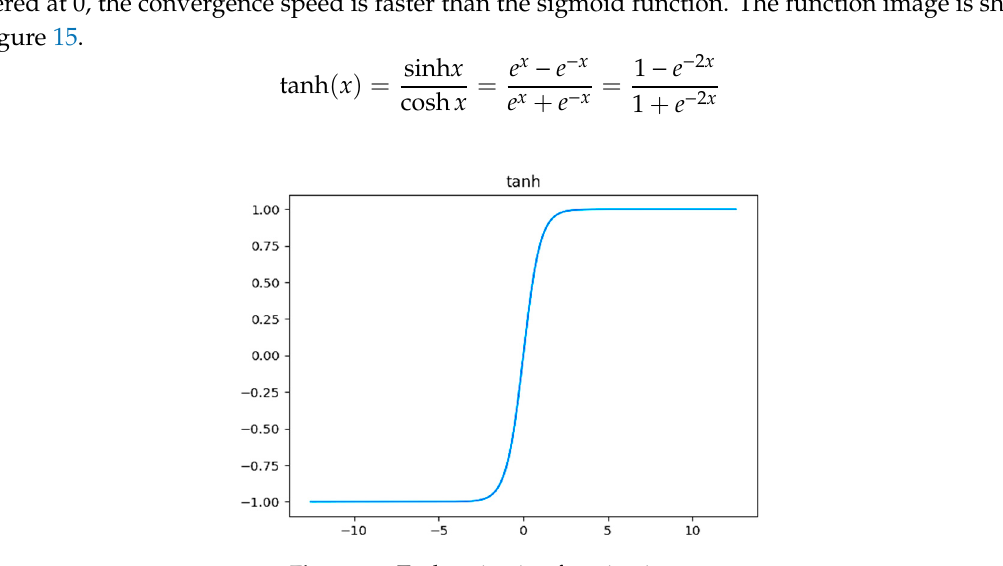
Figure 15. tanh activation function image.